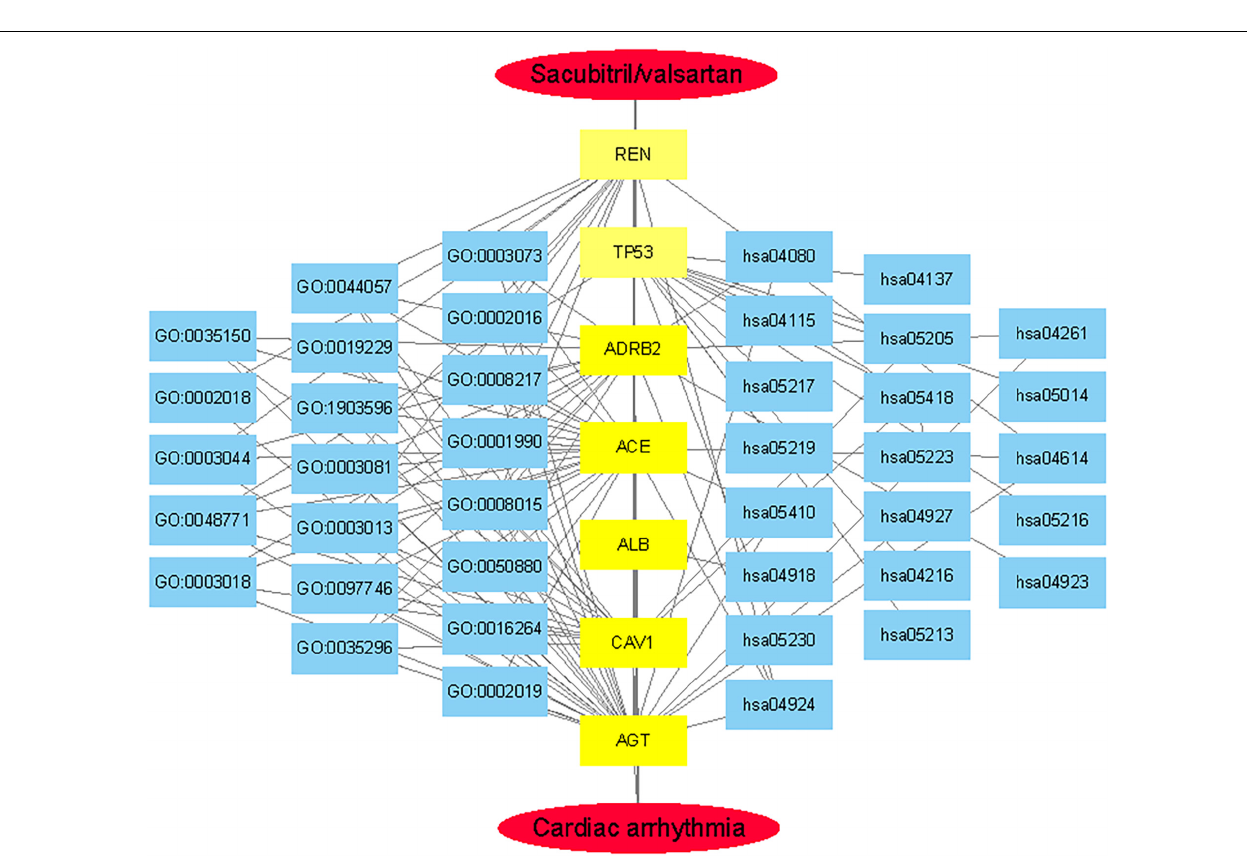
FIGURE 7 | The integrated SV-GO-KEGG-Anti-arrhythmia network was visualized by Cytoscape.